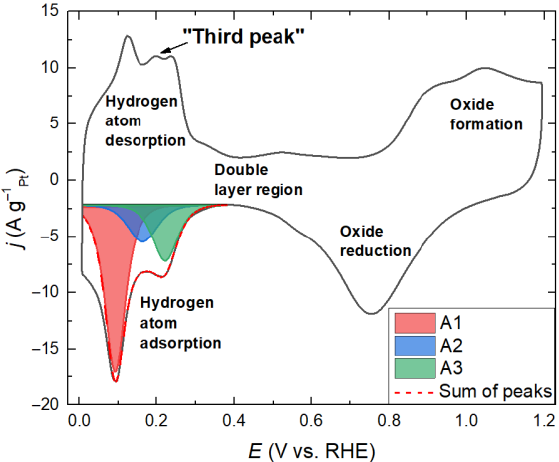
Figure 3. Pt 40 /C CV with the region of hydrogen adsorption fitted by three Frumkin isotherm peaks.